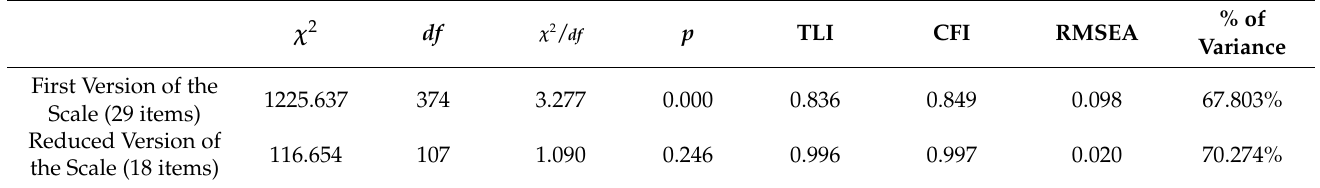
Table 3. Goodness-of-fit indices for the first version (29 items) and the reduced version (18 items) of the ECS-IN